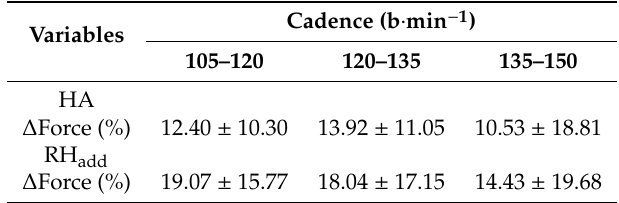
Table 3. Rate of force variation in the incremental protocol (Mean ±